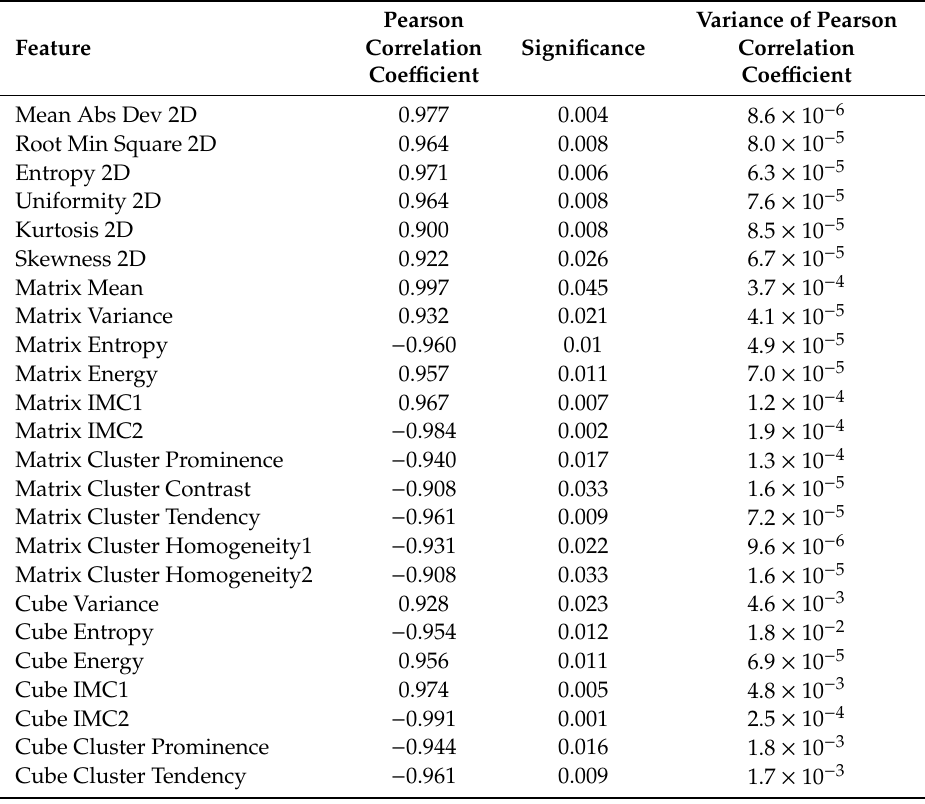
Table 2. Pearson correlation coe ffi cients and significance level for MRI-based imaging features, which exhibit correlation with